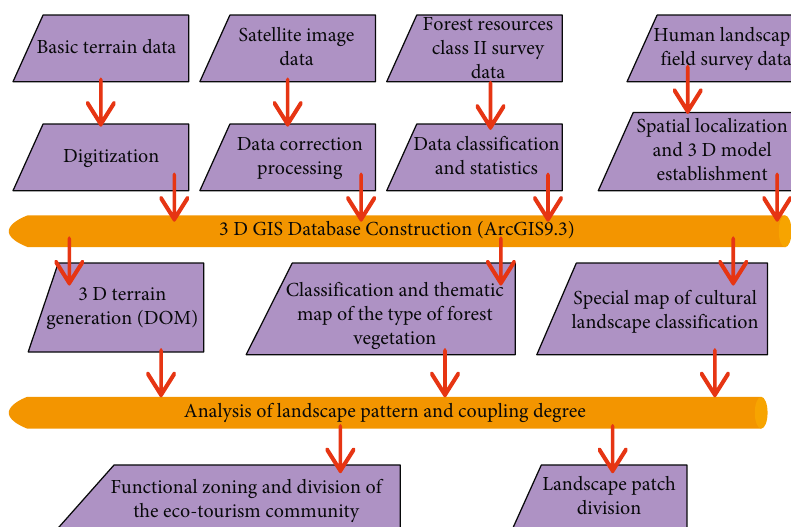
Figure 6: Visualization of sustainable development garden landscape.